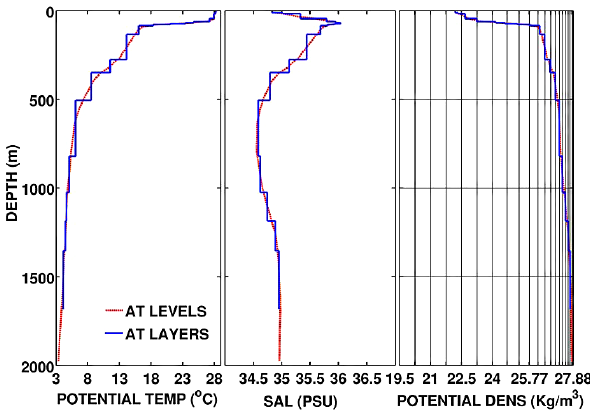
Figure 2. Profile of potential temperature ( ◦ C), salinity (psu) and potential density (kgm − 3 ) from an Argo float located at 4.04 ◦ N and 23 ◦ W on 1 January 2010 plotted against its approximation for HYCOM as layer averages. The model target density is indicated by the solid black vertical